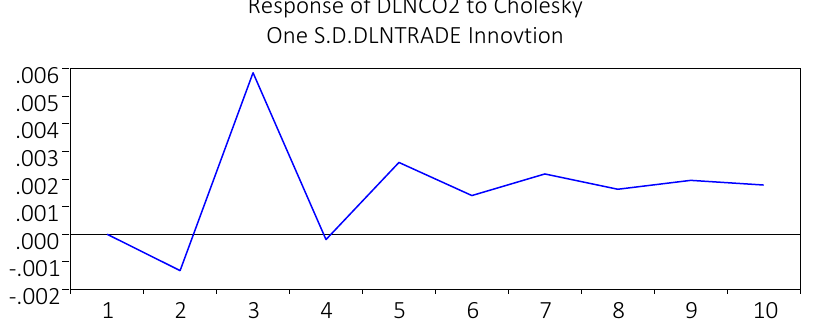
Figure 4a. Trade openness policy response on CO